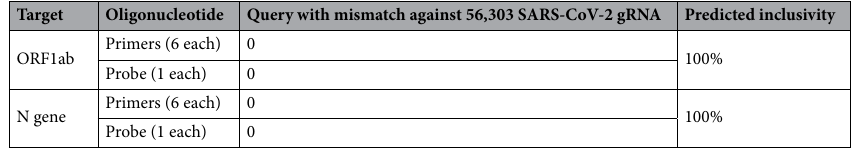
Table 1. Summary of oligonucleotide sequence analysis. Sequences of all primer and probes showed no mismatch against the target queries (SARS-CoV-2 whole genomic